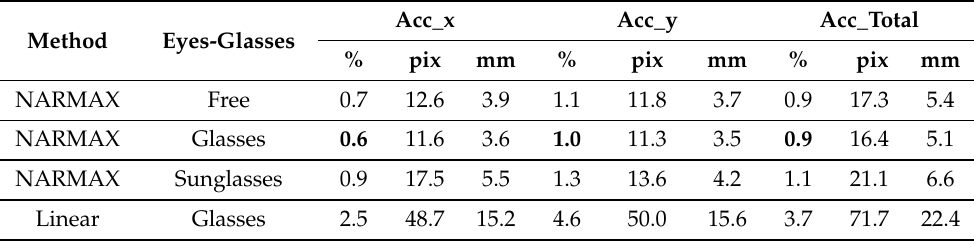
Table 3. Testing accuracy vs. glasses on a 1920 × 1080 screen. Test done by one person looking at eight points on a screen. Test was done 5 times using NARMAX